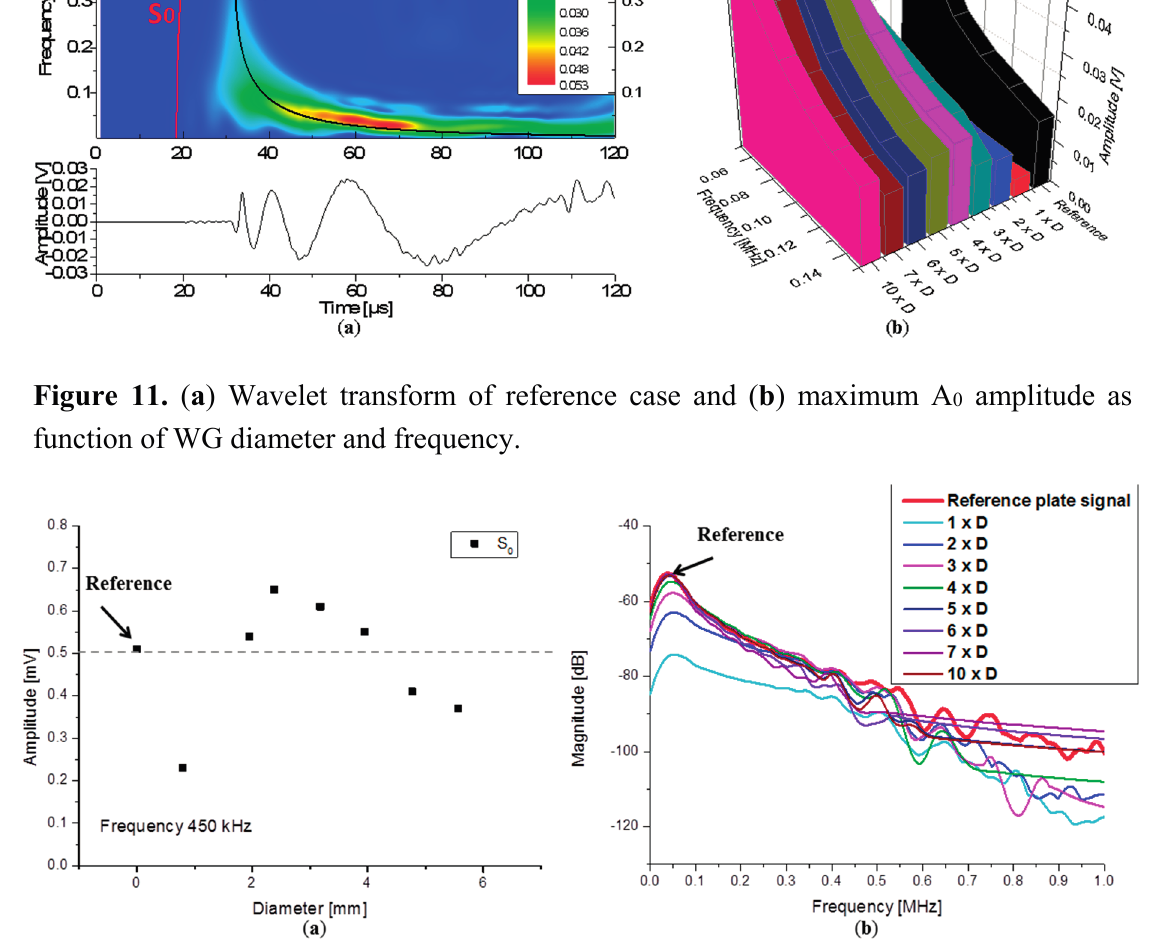
Figure 12. Magnitude ( a ) of S 0 mode from WT ( b ) from